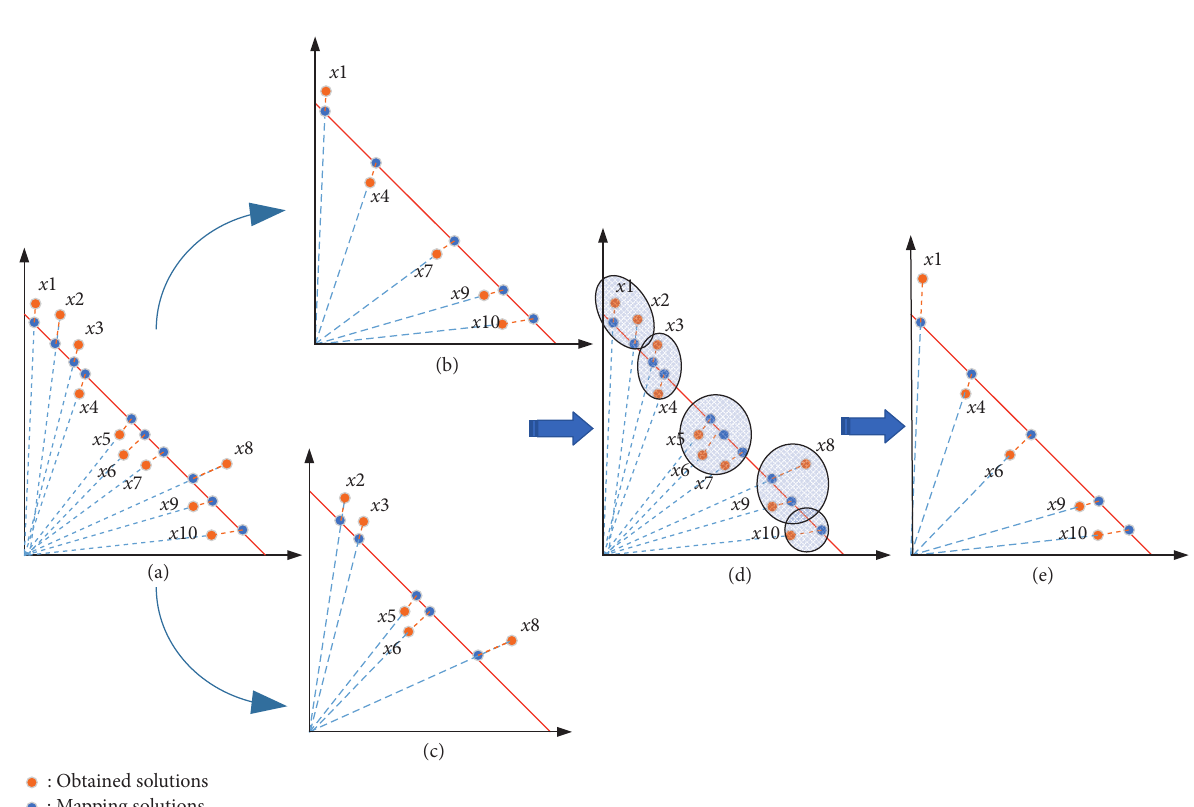
Figure 1: An example to illustrate the process of the proposed angular-guided archive update